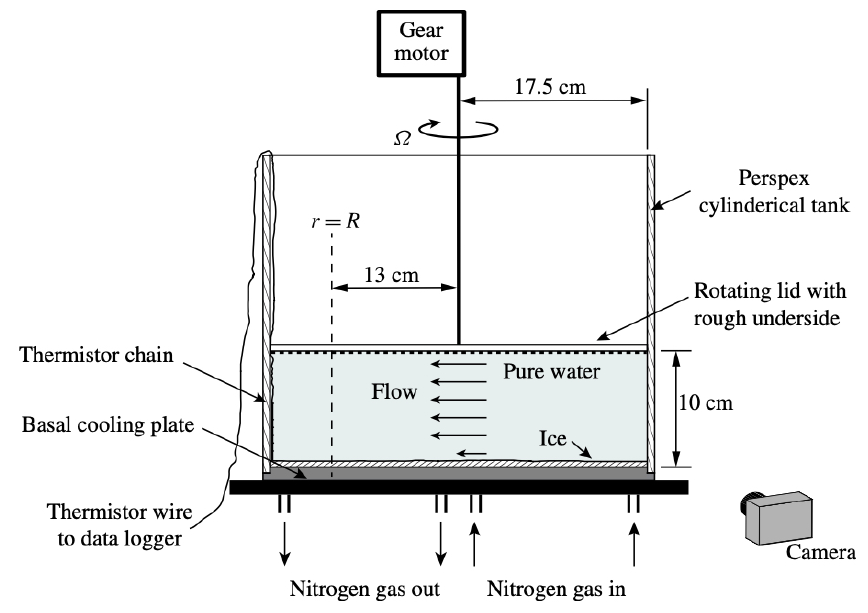
Figure 5. A schematic of the apparatus of [65], reproduced with permission from Cambridge Uni- versity Press (2016), with a rotating lid to produce turbulent flow above an ice sheet located at the bottom of the